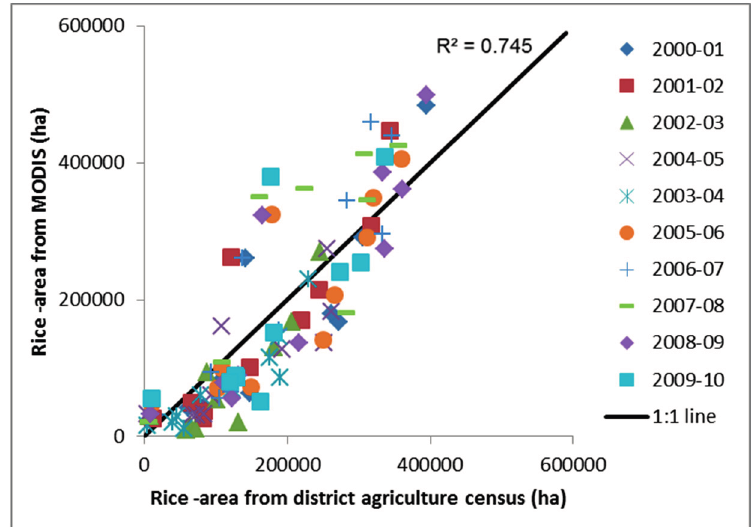
Figure 12. The district level comparison of rice cropped areas between agriculture census dataset and MODIS-500 m derived dataset (year wise 2000–2001 to 2009–2010). Numbers of samples are 10 districts per year and number of years are 10. Areas shown on X- and Y-axes are in hectares.